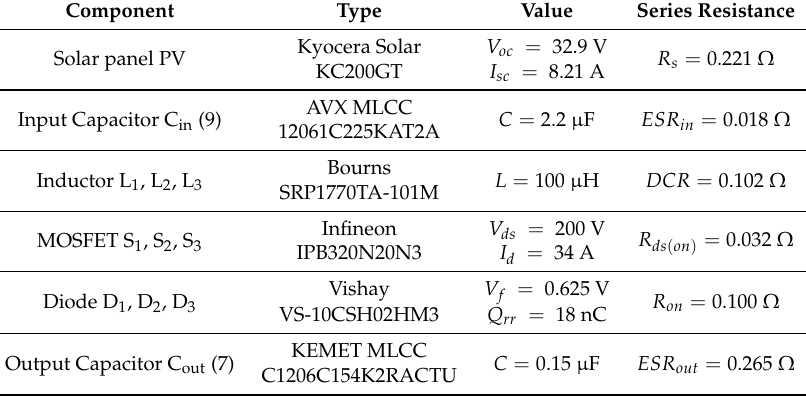
Figure 3. Photograph ( left ) of the printed circuit board assembly and the schematic ( right ) of a three-leg interleaved boost converter for photovoltaic applications. Table 1. The components used in the interleaved boost converter together with their key parameters and series